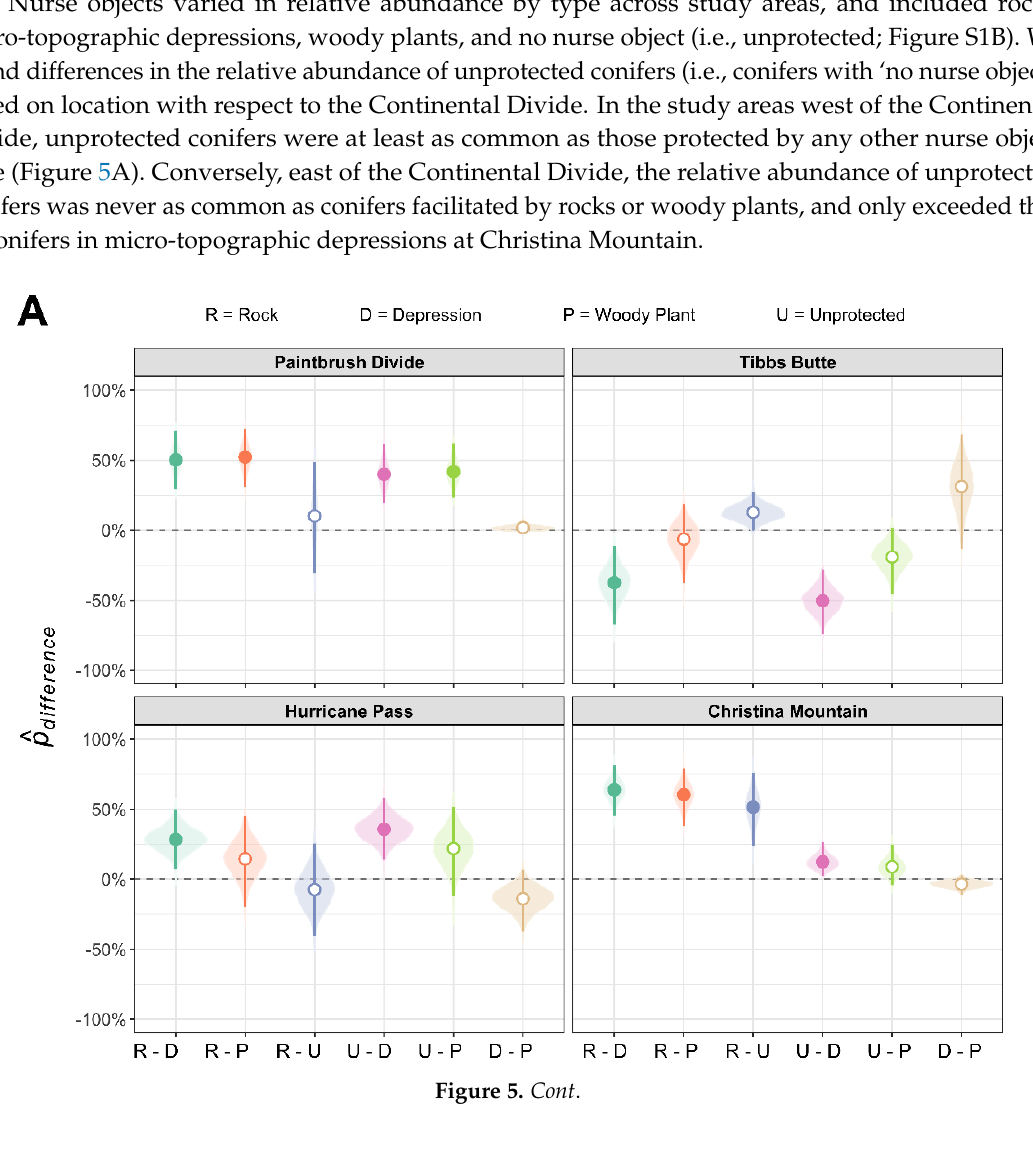
Figure 5. Parameter estimates for nurse object facilitation. ( A ) Pairwise mean differences in relative abundance between nurse objects. ( B ) Nurse object relative abundances. Shaded curves delineate sampling distributions, circles indicate parameter estimates, and vertical lines delineate 99.2% CIs ( A ) or 95% CIs ( B ). Closed circles in ( A ) denote significant differences.